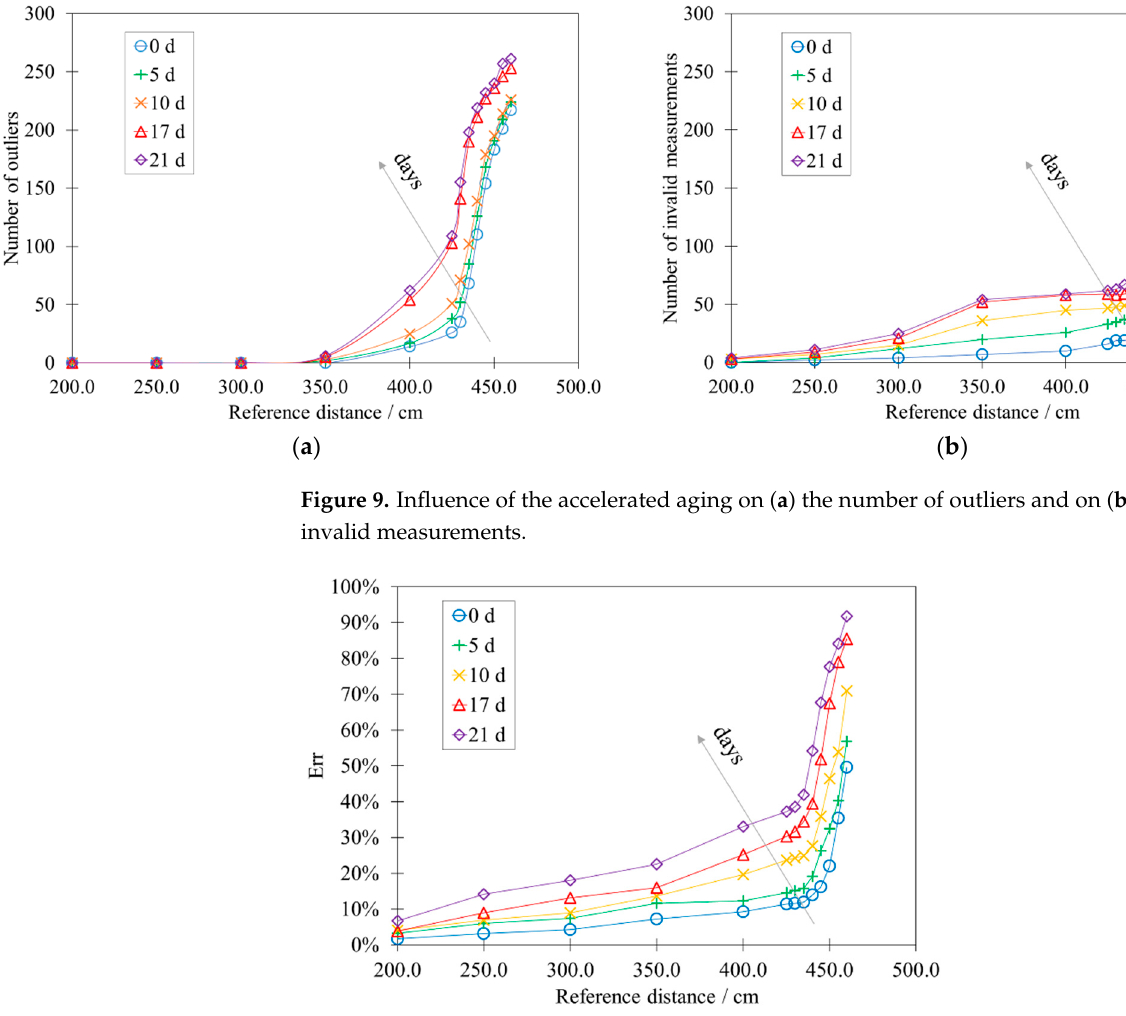
Figure 10. Influence of the accelerated aging on the percentage error Err .